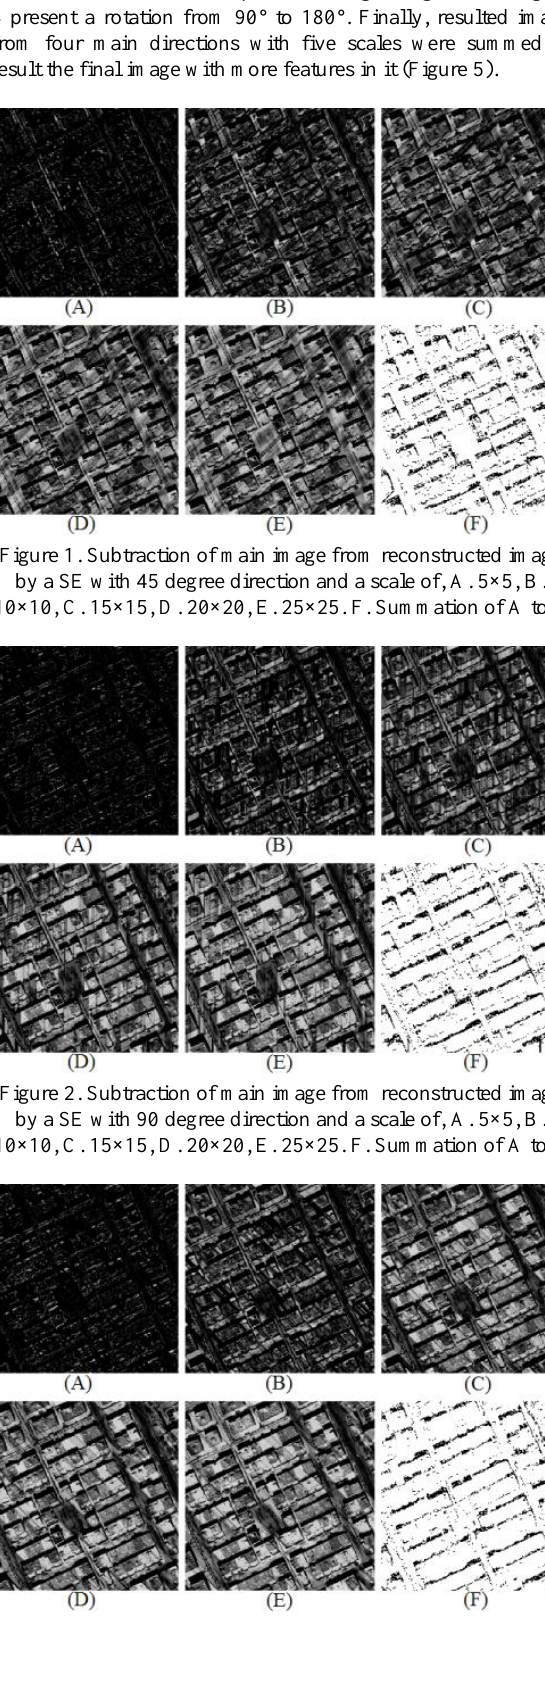
Figure 3. Subtraction of main image from reconstructed image by a SE with 135 degree direction and a scale of, A. 5×5, B.